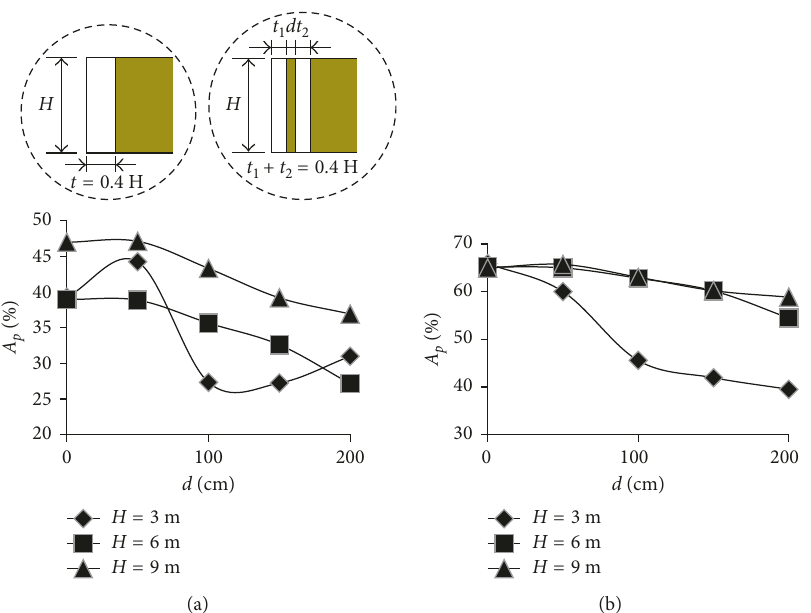
Figure 7: Effects of one geofoam panel and two geofoam panels with the relative thickness of 0.4H in various panel spacing on reduction of wall forces: (a) yielding retaining wall and (b) nonyielding retaining